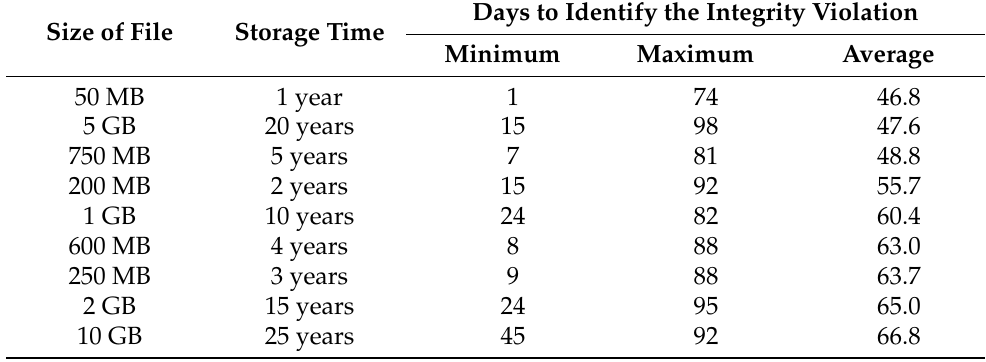
Table 7. Summary of results by file size and storage